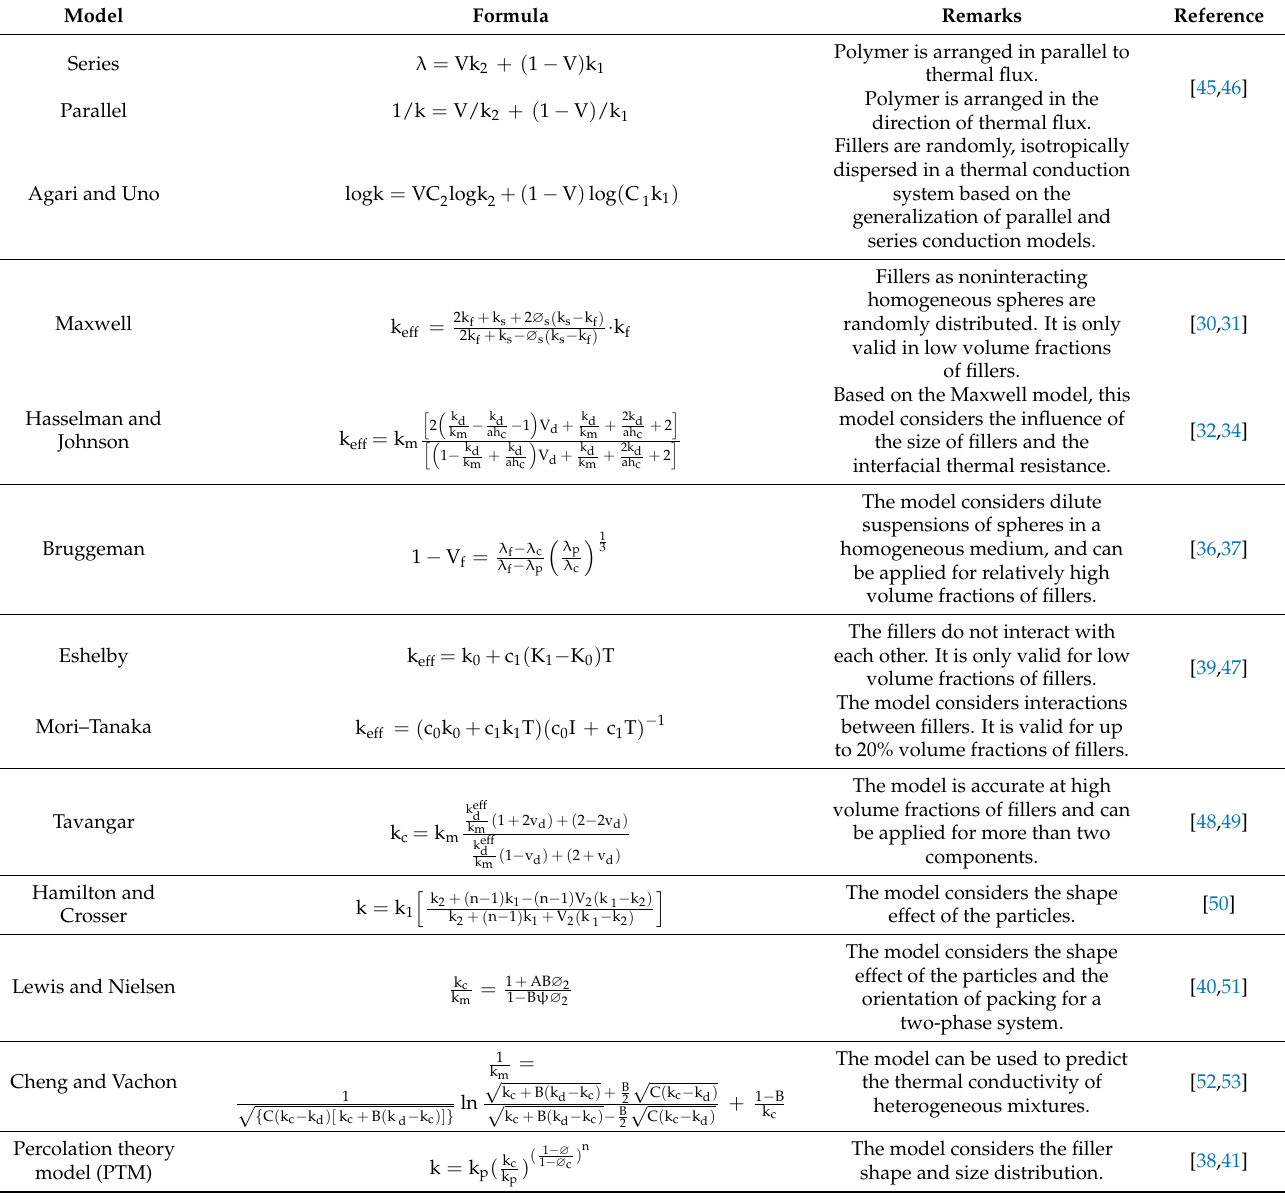
Table 1. Typical thermal conductivity models of composite-based